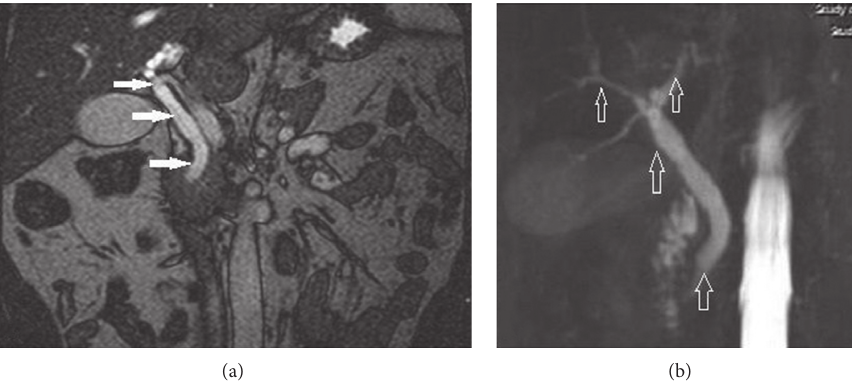
Figure 2: MRI image showing (a) dilation of hepatic and common bile duct (white arrows). MRCP image showing (b) full-length dilation of biliary tree